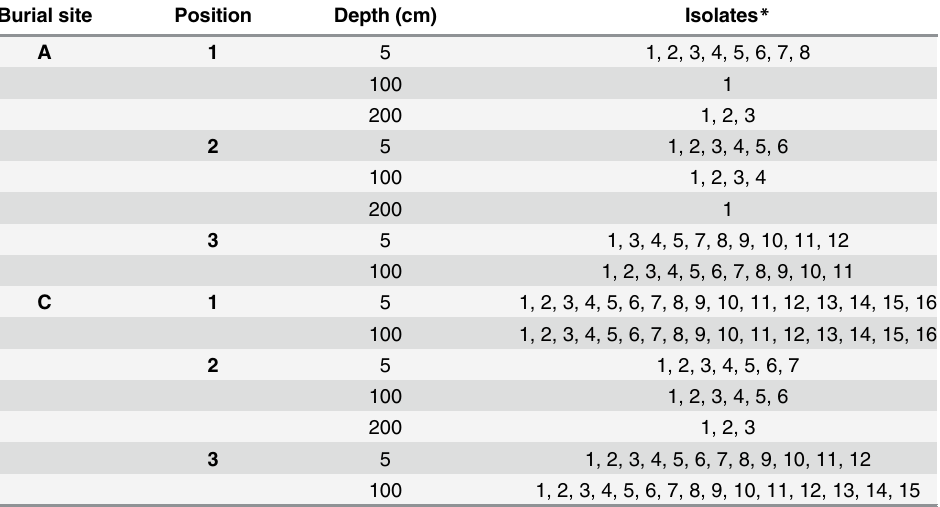
drill out of the hole, all the soil coating the drilling core was removed with a clean knife and only the innermost part of the core was collected in a 50 ml sterile plastic tube. Table 1. Strains of B . anthracis isolated from soil samples of Pollino National Park. Isolates character- ized in Germany or Italy are labeled with numbers or letters, respectively. Isolate nomenclature is defined by burial site (letter) sampled position (number/), its depth (cm), and a successive number 1 or letter 2 throughout the manuscript, e.g., C1/5 cm – 1. Burial site Position Depth (cm) Isolates *